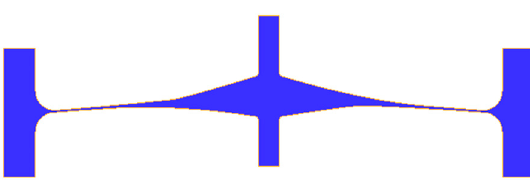
Figure 18. Shapes of the actuator for the compromise-solution chosen by consecutive steps indicated in Figure 17.